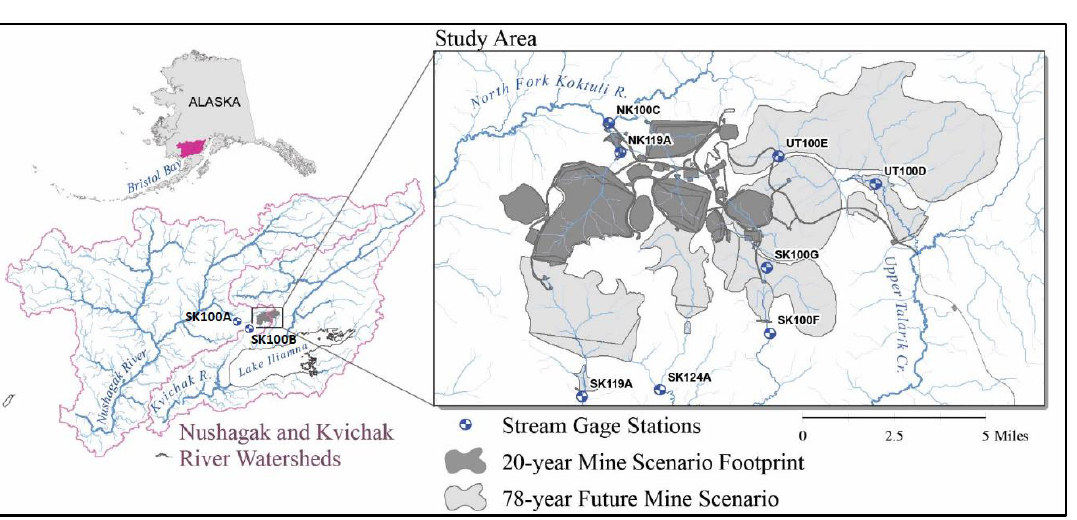
Figure 1. Pebble Project location, outline of the 20- and 78-year mine extents, and existing stream gage locations in the Upper Talarik (UT), South Fork Koktuli (SK), and North Fork Koktuli (NK) watersheds. Source: Map courtesy of David Albert/The Nature Conservancy, modified to add SK 100A and SK 100B stream gage locations.